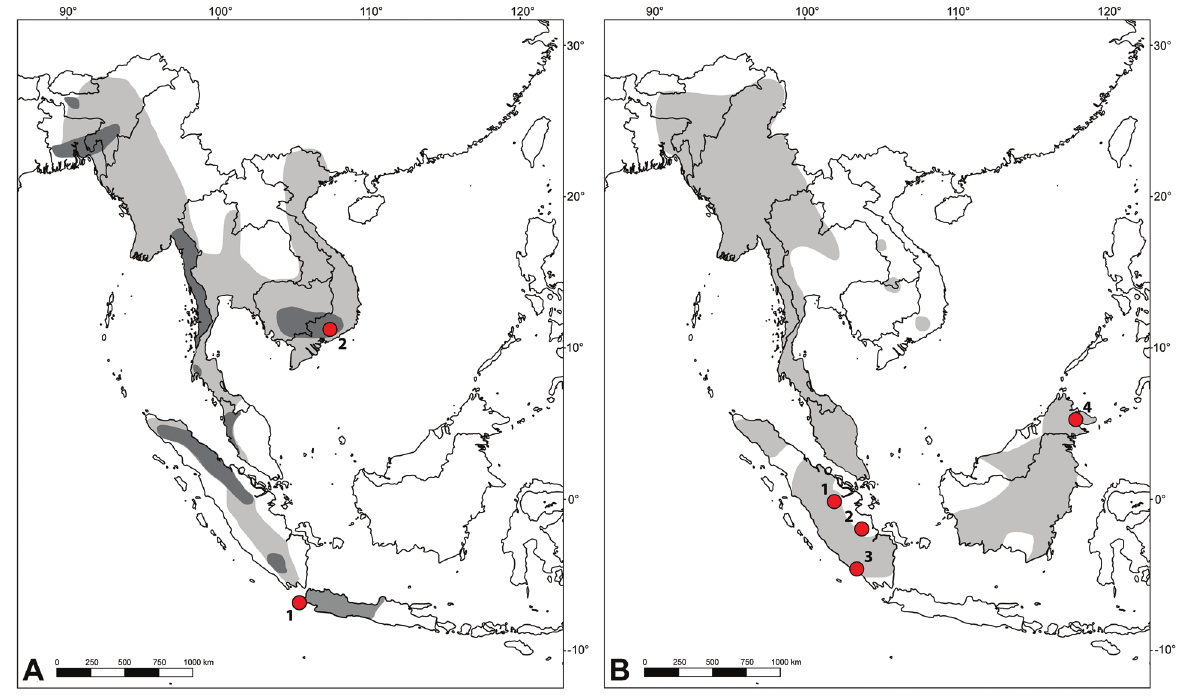
Figure 3. Historical distribution in Southeast Asia and origin of specimens used for molecular investigations of (A) the Javan rhi - noceros ( Rhinoceros sondaicus) , with the only extant location on Java (1) and last extinct one in Vietnam (2), and (B) Sumatran rhinoceros ( Dicerorhinus sumatrensis ) with locations: 1 - Riau, Sumatra; 2 - Djambi, Sumatra; 3 - Bengkulu, Sumatra; 4 - Sabah, Borneo. Light shaded area: distribution given by Foose and van Strien (1997); dark shaded area: distribution given by Groves and Leslie